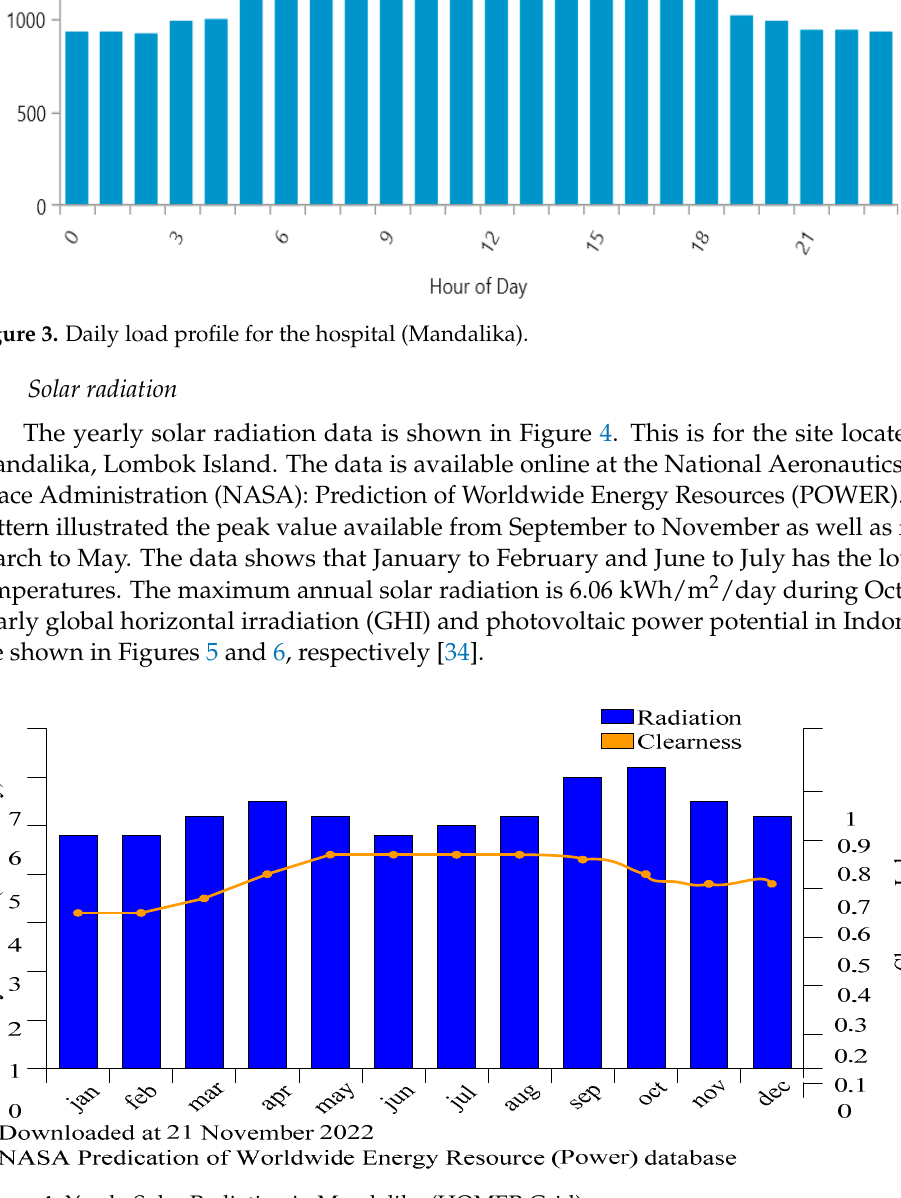
Figure 4. Yearly Solar Radiation in Mandalika (HOMER Grid).